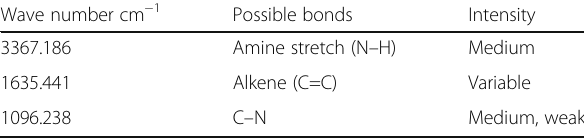
Table 2 Wave number represents the presence of bonds Wave number cm − 1